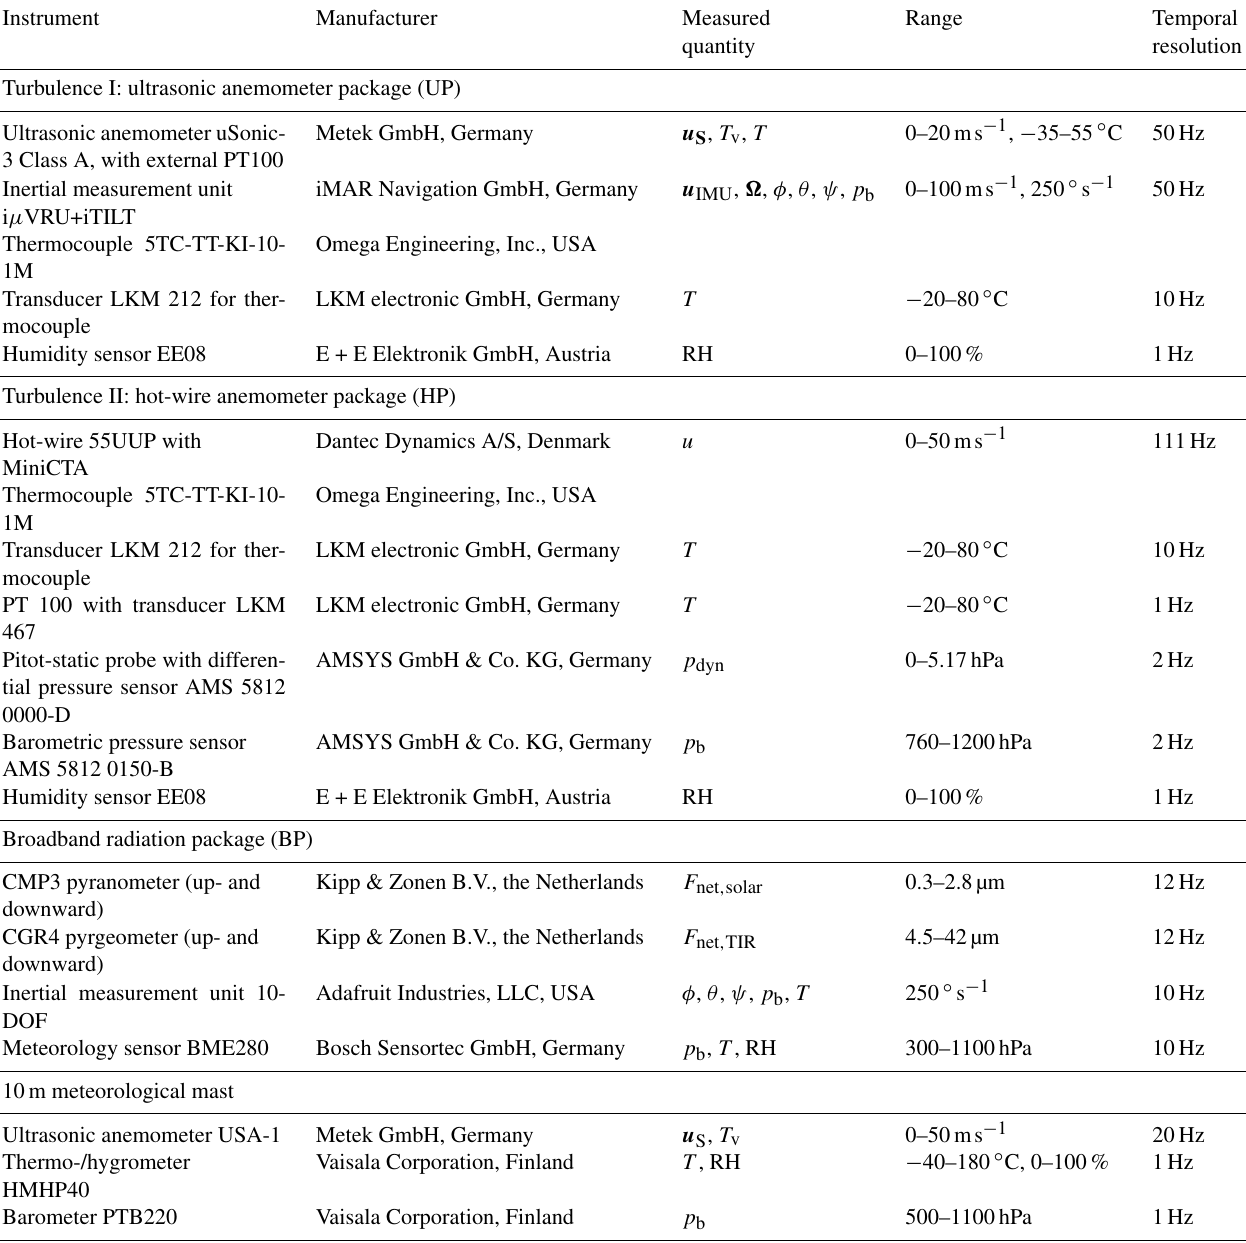
Table 1. Characteristics of the main instruments included in the particular balloon-borne sensor packages and on the 10m meteorological